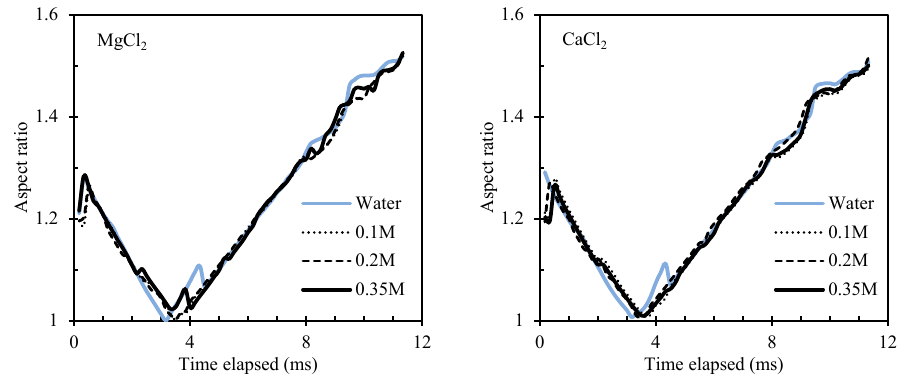
Figure A3. Aspect ratio in different salt solutions.